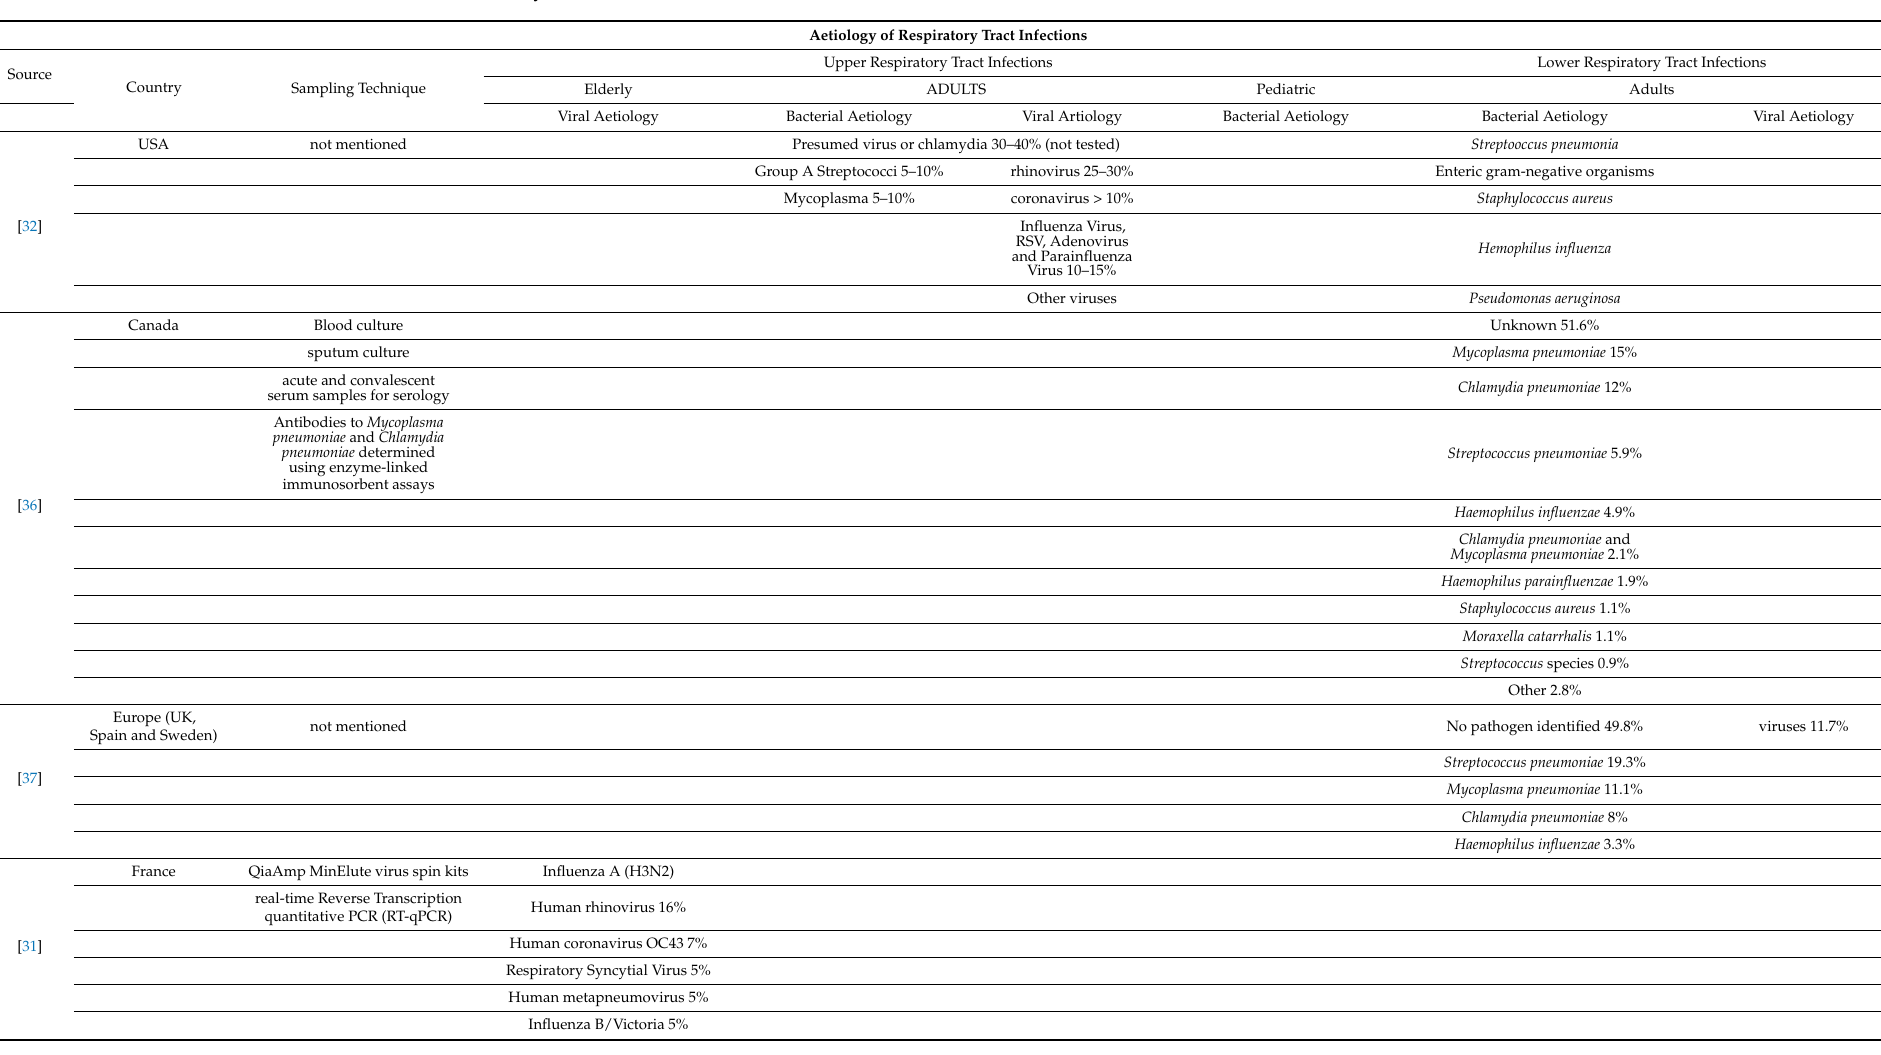
Table 2. Prevalence of causative pathogens of upper and lower respiratory tract infections in paediatric, adult, and older patients in the USA, Canada, Europe, France, Malawi, Turkey, and